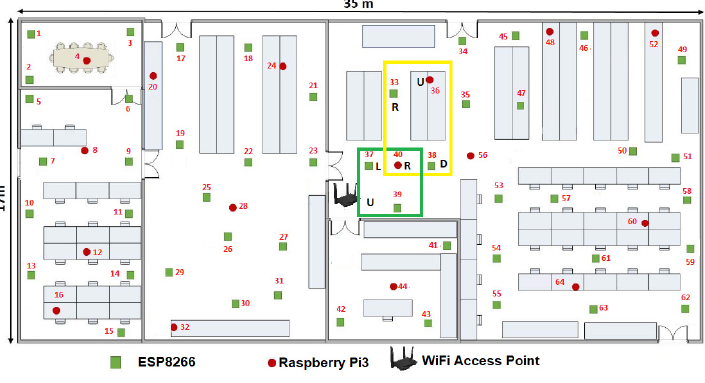
Figure 13. MCU 40 ( t 1 ) as the MCU seed using the axiom R −→ DRRU .